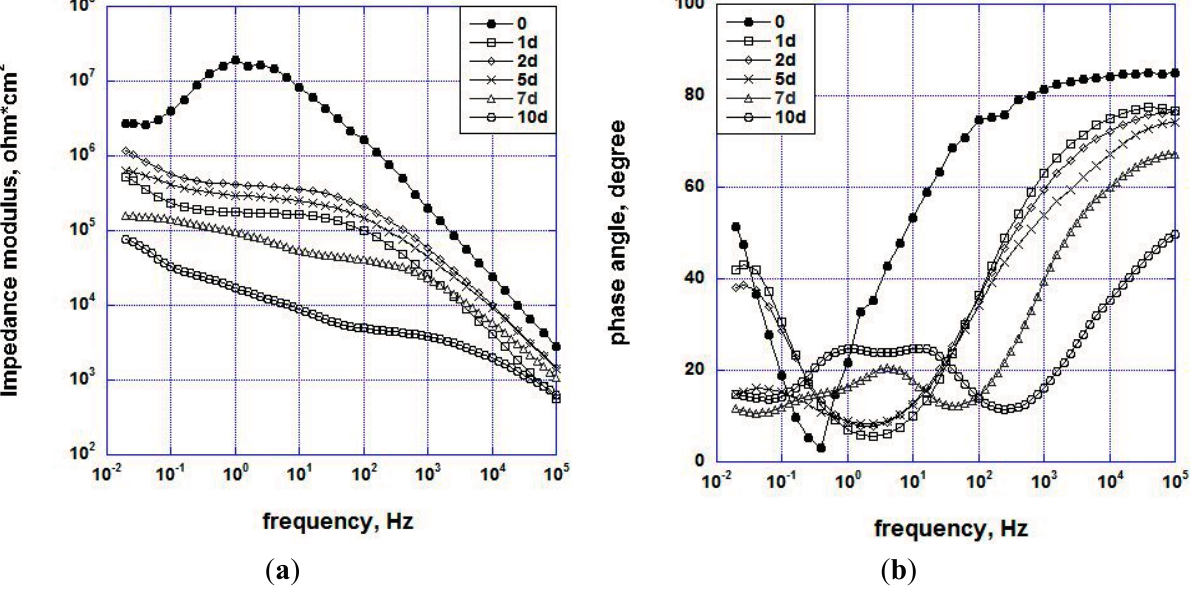
Figure 3. Bode plots for impedance modulus ( a ) and phase angle of sample coated with unfilled water-based epoxy resin ( b